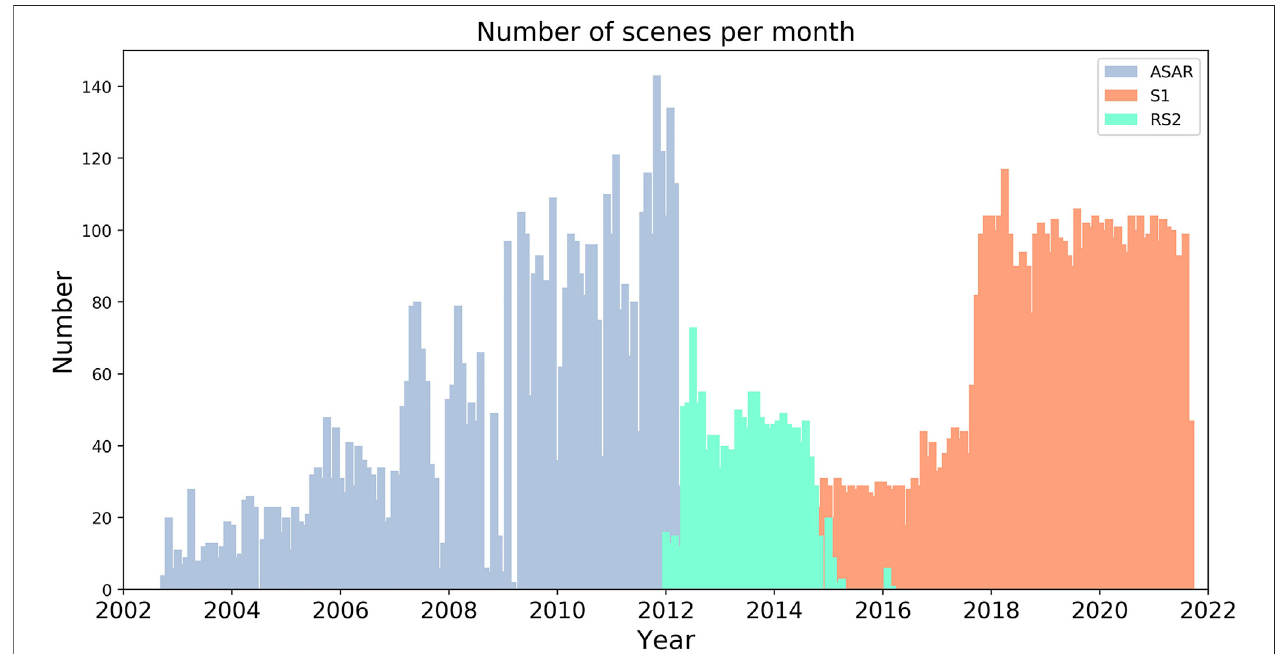
FIGURE 2 | Number of scenes available per month for each